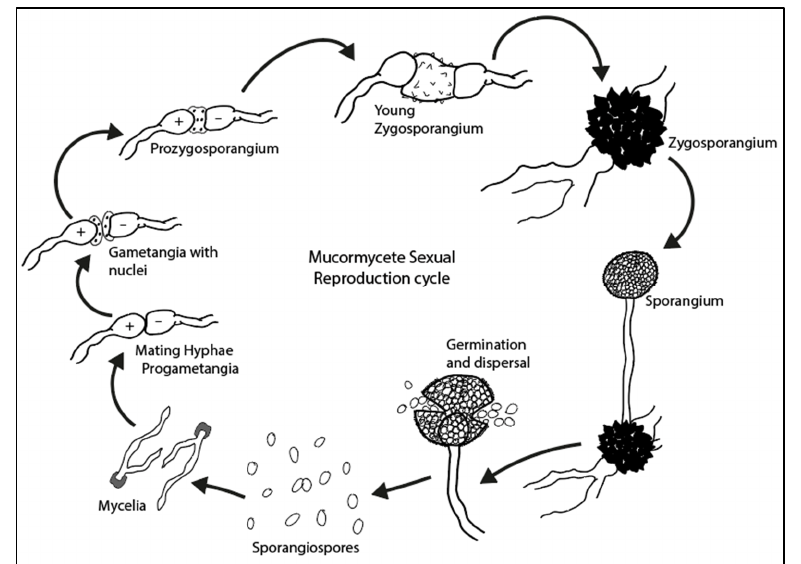
Figure 4. Generalised mucormycetes’ sexual reproduction cycle (adapted after Nwe et al. [44]). Mycelia is the plural form of mycelium. Progametangia is the hyphal threads on the tip of which the gametangia form. The gametangia are the sex organs of fungus. The fusion of + and − nuclei is referred to as the prozygosporangium. The young zygosporangium forms from the prozygosporangium secreting a heavy wall. This then matures to become the zygosporangium. Once this cracks, the up-right hypha called promycelium form, which has the sporangium at its top. The sporangium is the enclosure in which spores, in this case known as sporangiospores, from [45].